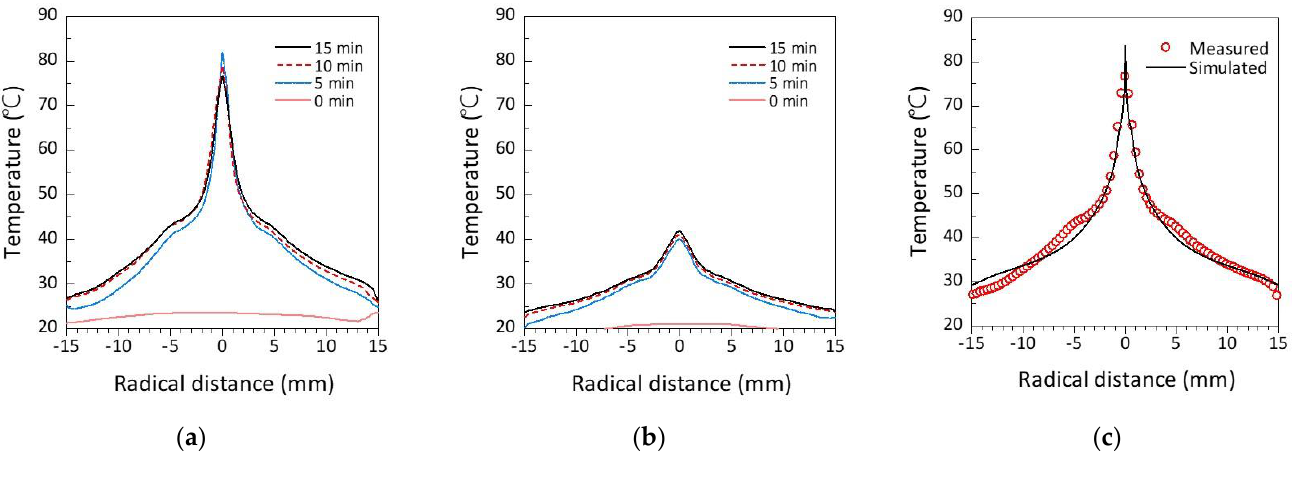
Figure 9. Radial temperature distribution across mouse skin during ( a ) contact plasma treatment, and ( b ) non-contact plasma treatment. In ( c ), the measured radial temperature distribution across mouse skin for contact plasma treatment is compared to a COMSOL Multiphysics simulated temperature profile.